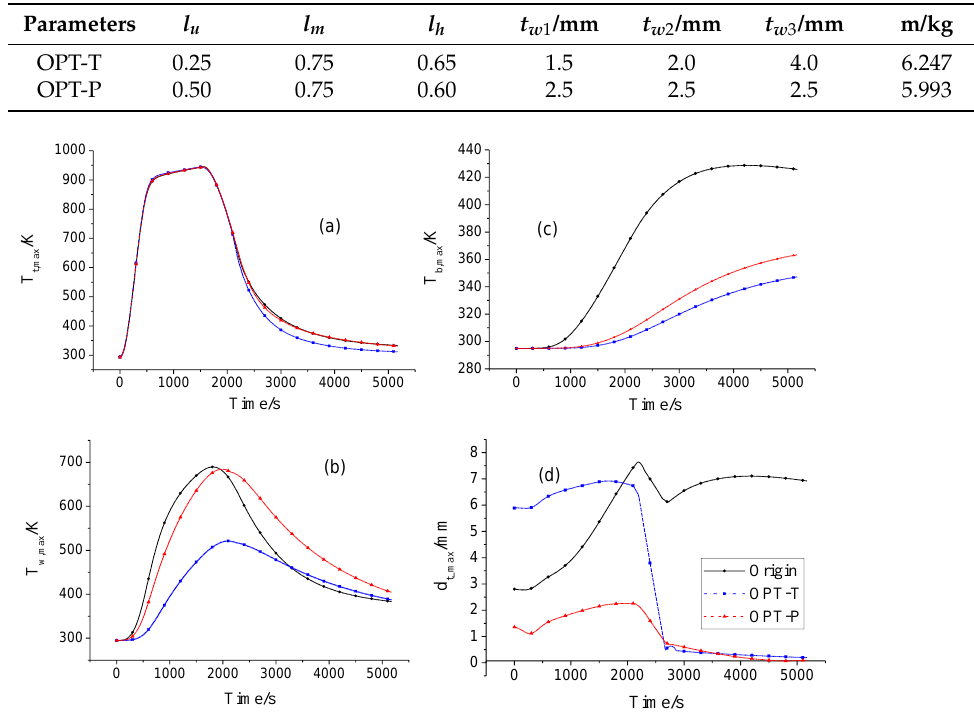
Figure 11. Temperature distribution comparison of ( a ) origin design and OPT-T and ( b ) origin design and OPT-P. Maxi- mum deformation comparison of ( c ) origin design and OPT-T and ( d ) origin design and OPT-P. Deformations were controlled by the coupled thermal and mechanical loads before the time of 2100 s. After 2100 s, pressure load on the outer surface of TFS gradually ele- vated and counterbalanced the pressure on the inner surface. Thus, along with the tem- perature decrease of the TFS, 𝐷 𝑡,max declines rapidly during the period around 2100 s to 2500 s. The main difference between the initial design and optimized designs lies in the